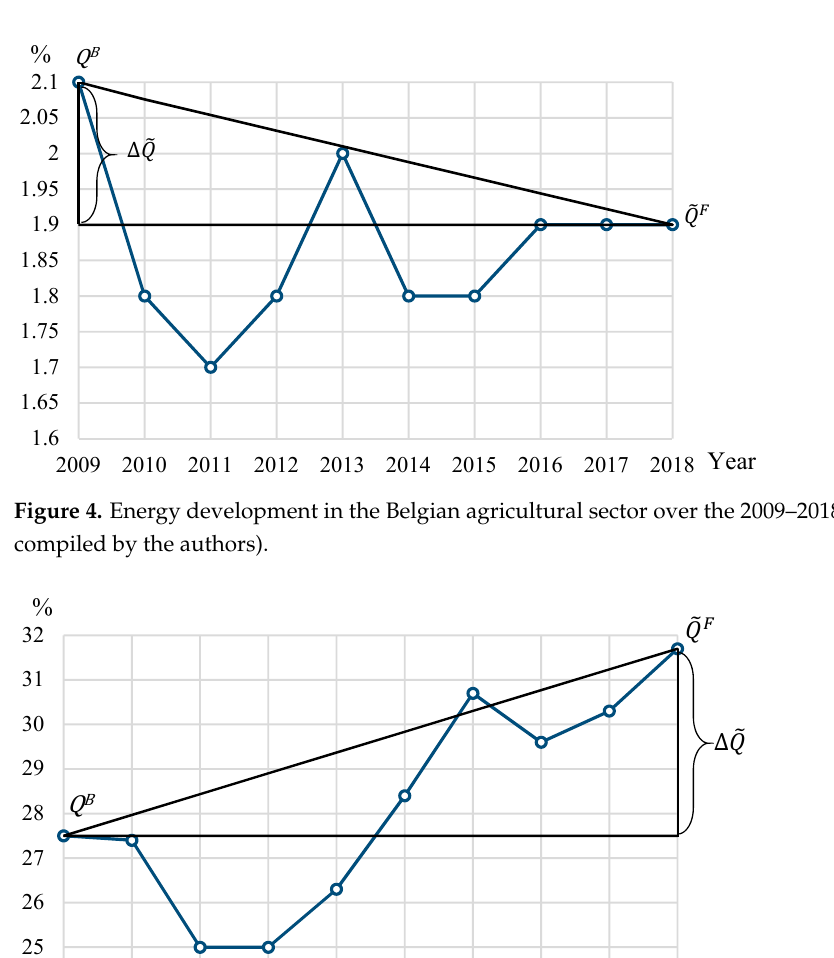
Figure 3. Energy development in the Slovak industrial sector over the 2009–2018 period (source: compiled by the authors).